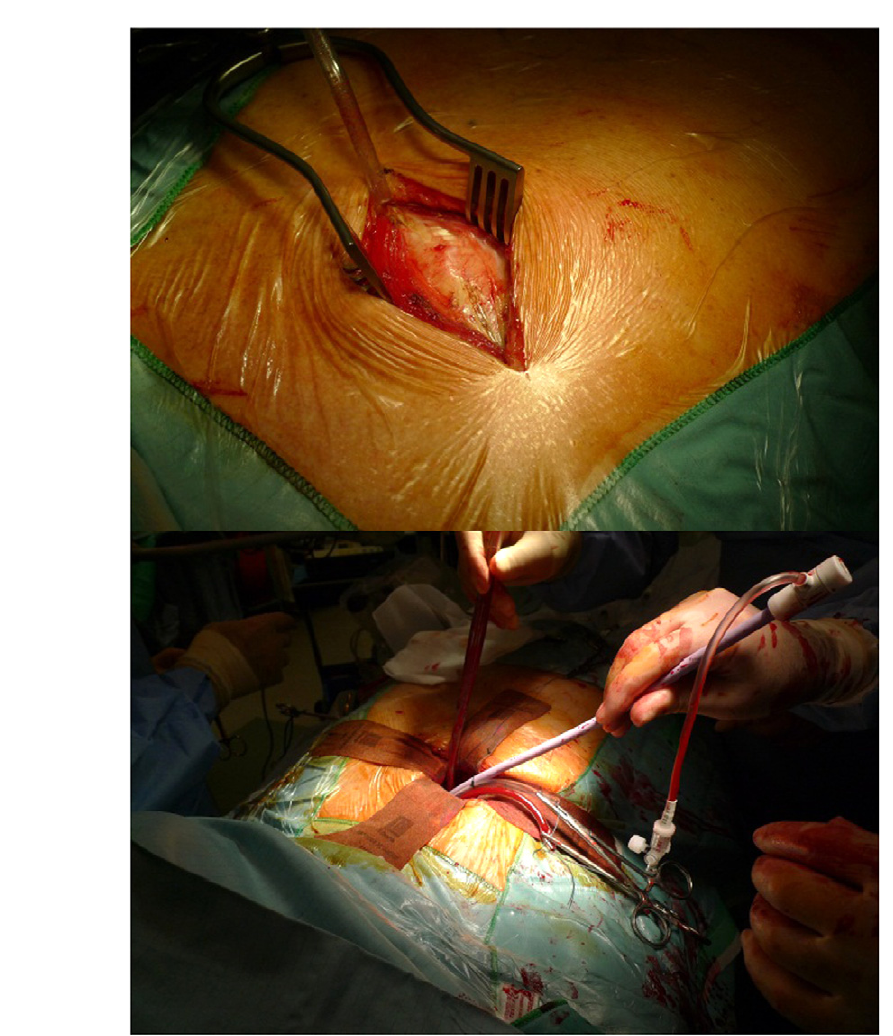
Figure 7a. Step-by-step TAVI via direct aortic approach. Top: Right upper parasternal mini-thoracotomy (second intercostal space) with excision of second intercostal cartilage. Bottom: Under direct visualisation, the ascending aorta is directly cannulated with 18-Fr Cook